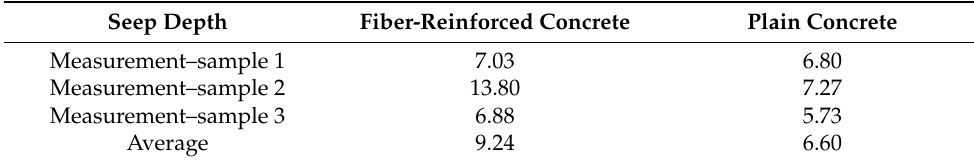
Table 5. Depth of penetration with pressurized water (mm).